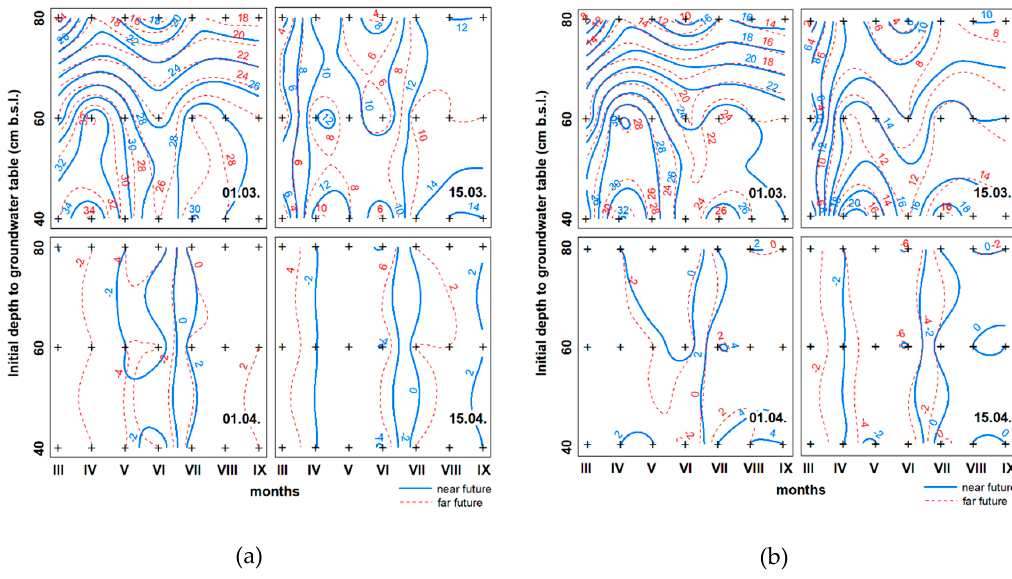
Figure 6. Average increases in groundwater tables in successive months for near and far future with different dates for blocking the outflow from the network with spacing of 7 m ( a ) and 14 m ( b